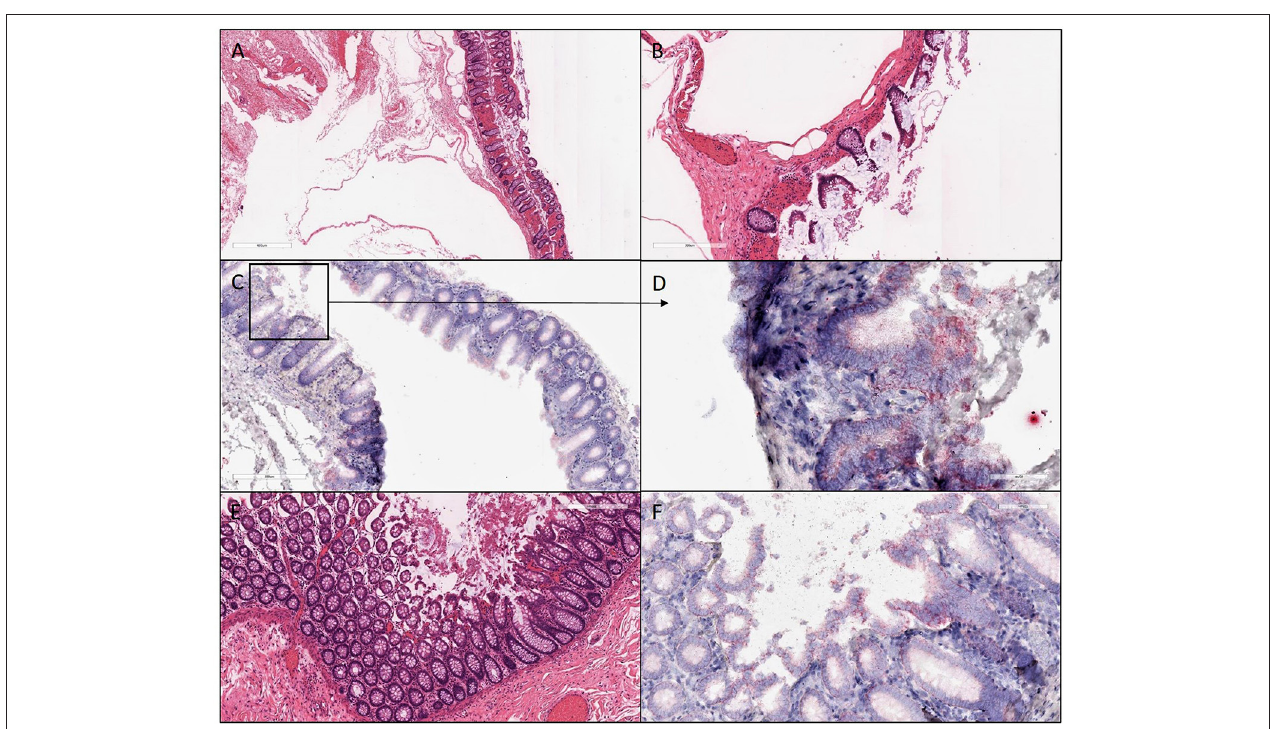
FIGURE 4 | H&E and ISH images of patient #3 in focal mucosal ulcer with granulation tissue formation along with adjacent uninvolved mucosa. (A,B) H&E images of ischemic colon tissue sections at 4X and 10X magnification, respectively. (C,D) Images at lower (10X) and higher magnification (40X), respectively, after in situ hybridization using V-nCOV2019—orf1ab–sense probe (red chromogen) More viral load of replicating SARS-COV-2 RNA was detected in this ischemic section as compared to its uninvolved mucosa represented in (F) . (E) H&E images at 10X of adjacent uninvolved mucosa (F) i n situ hybridization using V-nCOV2019—orf1ab- sense probe detected as red signal in adjacent intact epithelium of uninvolved mucosa at 20X